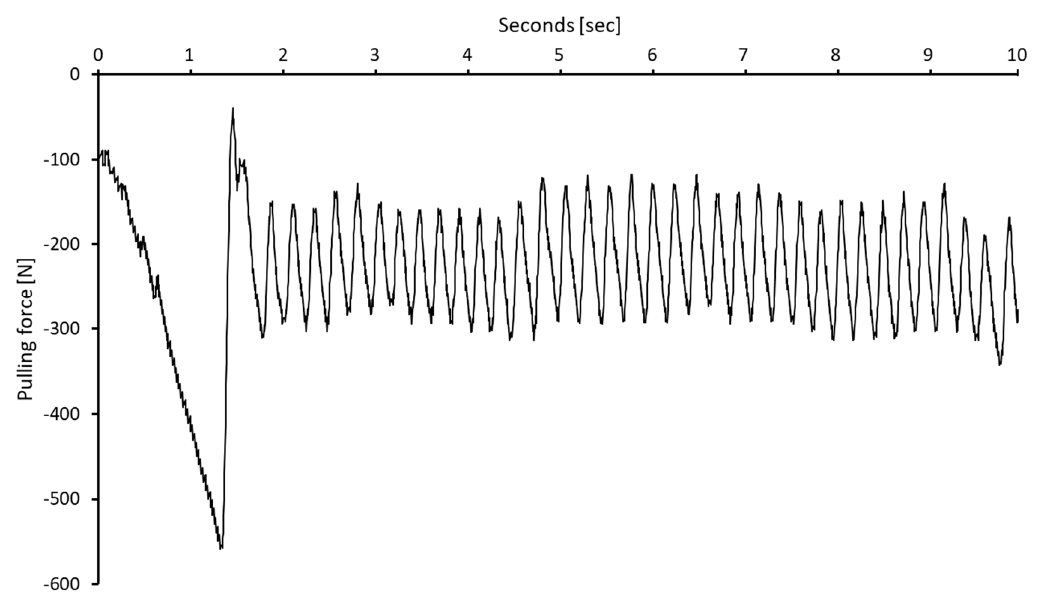
Figure 13. Example of a typical pulling force measuring curve of the watered treatment, with stick and slide effect.